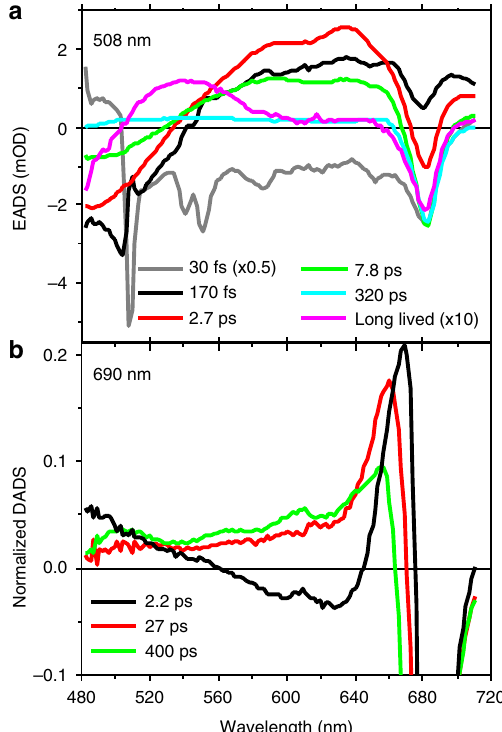
Fig. 2 Results of the global analysis after selective excitation of Cars and Chls. a EADS estimated from the global analysis of the data collected upon 508 nm (Cars) excitation. The gray and magenta EADS associated to ultrafast ( < 100 fs) and long-lived ( > ns) species, respectively, have been scaled for clarity as indicated in the legend. Given the short timescale (30 fs), coherent artifacts are likely present in the gray spectrum. b First three DADS normalized to their minimum for the data collected upon 690 nm (Chls) excitation. The full set of EADS and DADS for both excitation wavelengths is reported in Supplementary Figure 2a,